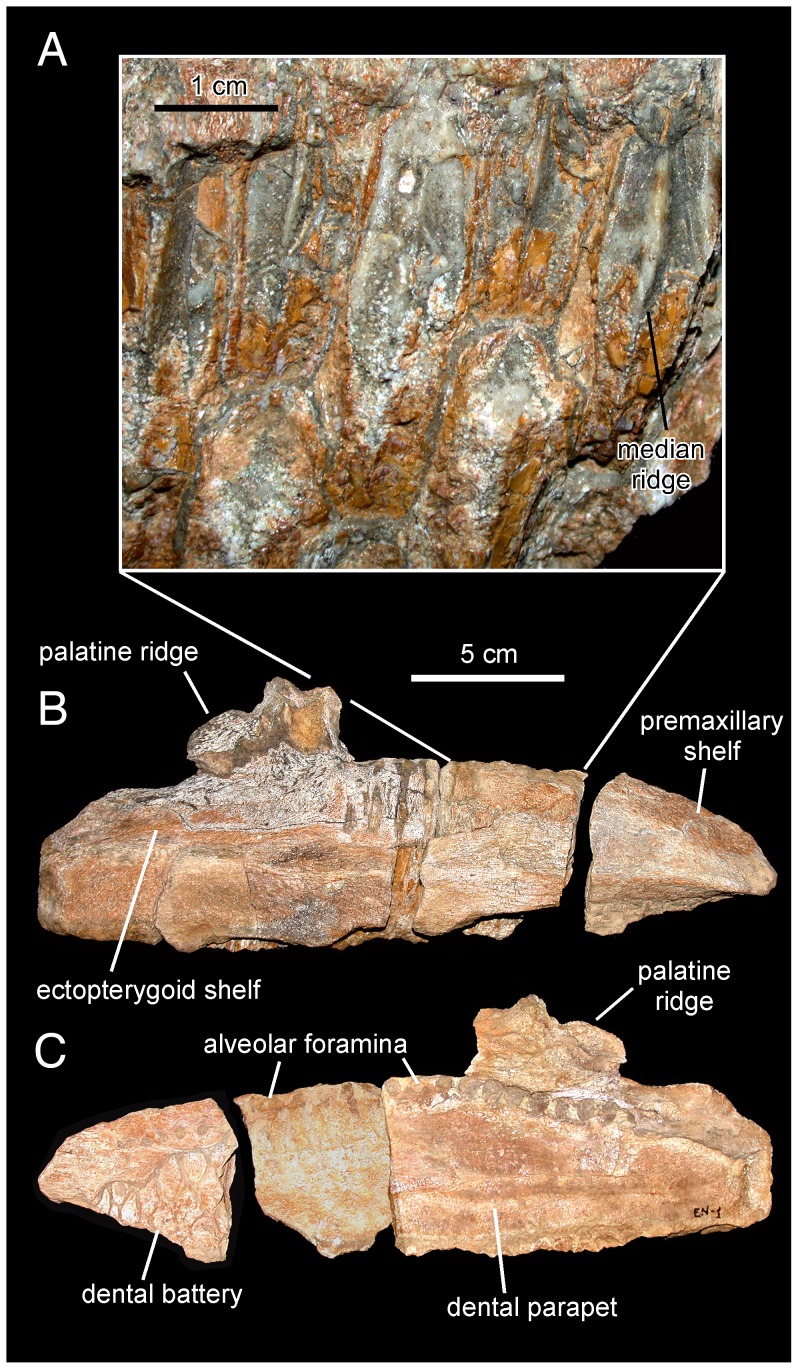
Indeterminate hadrosaurid maxilla from Euroda Nord.A. Maxillary tooth crowns (MCD 5090) in labial view. B. Lateral view of the maxilla. C. Medial view of same.